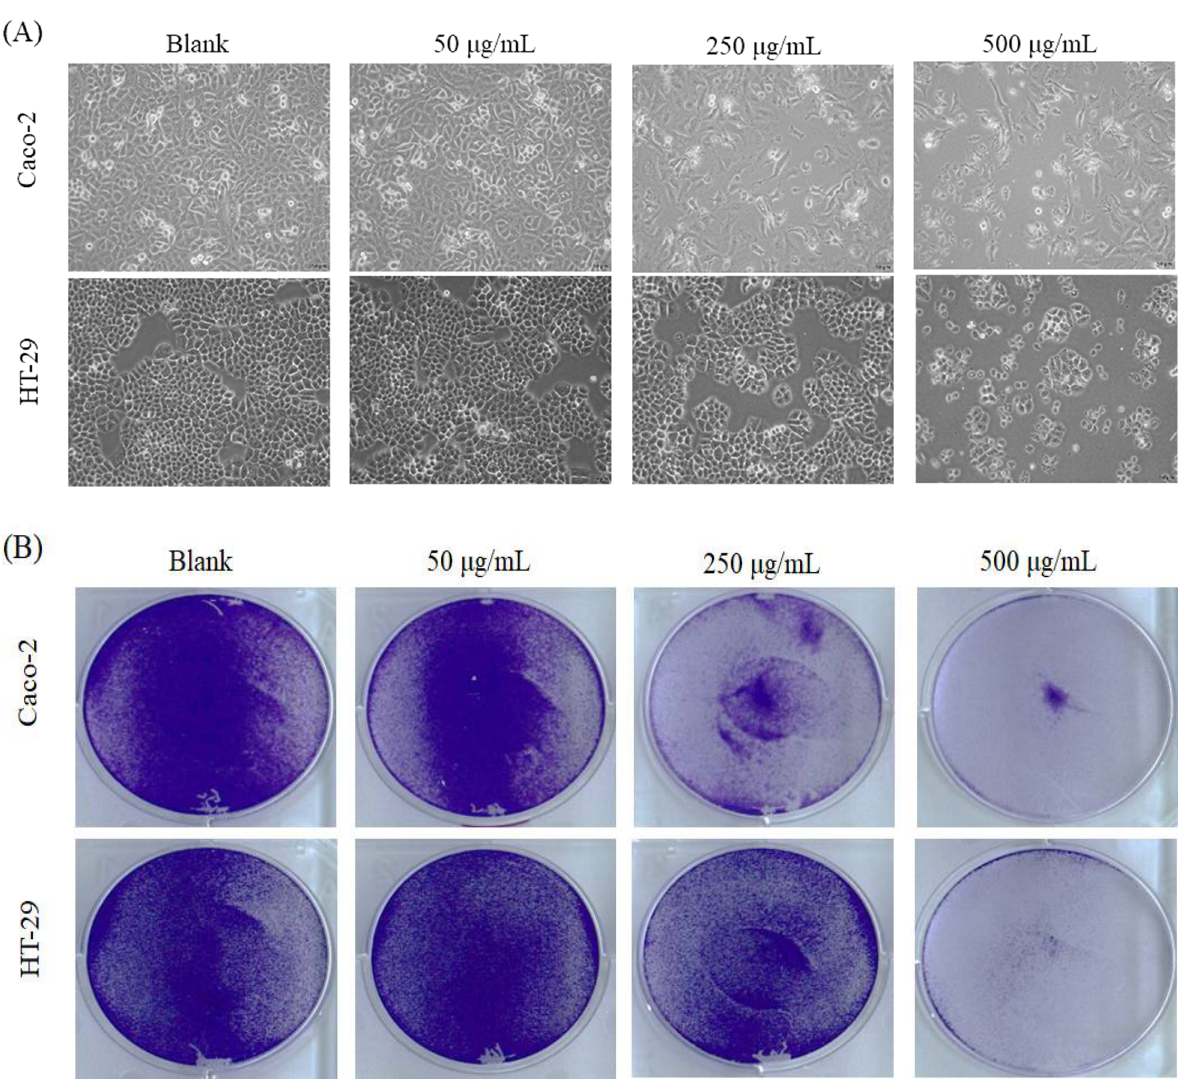
Figure 2. Cell viability of Caco-2 colorectal carcinoma cells after treatment with WEFPP ( A ) or EEFPP ( B ) for 24 h and 48 h. Data are shown as means ± SD ( n = 3).